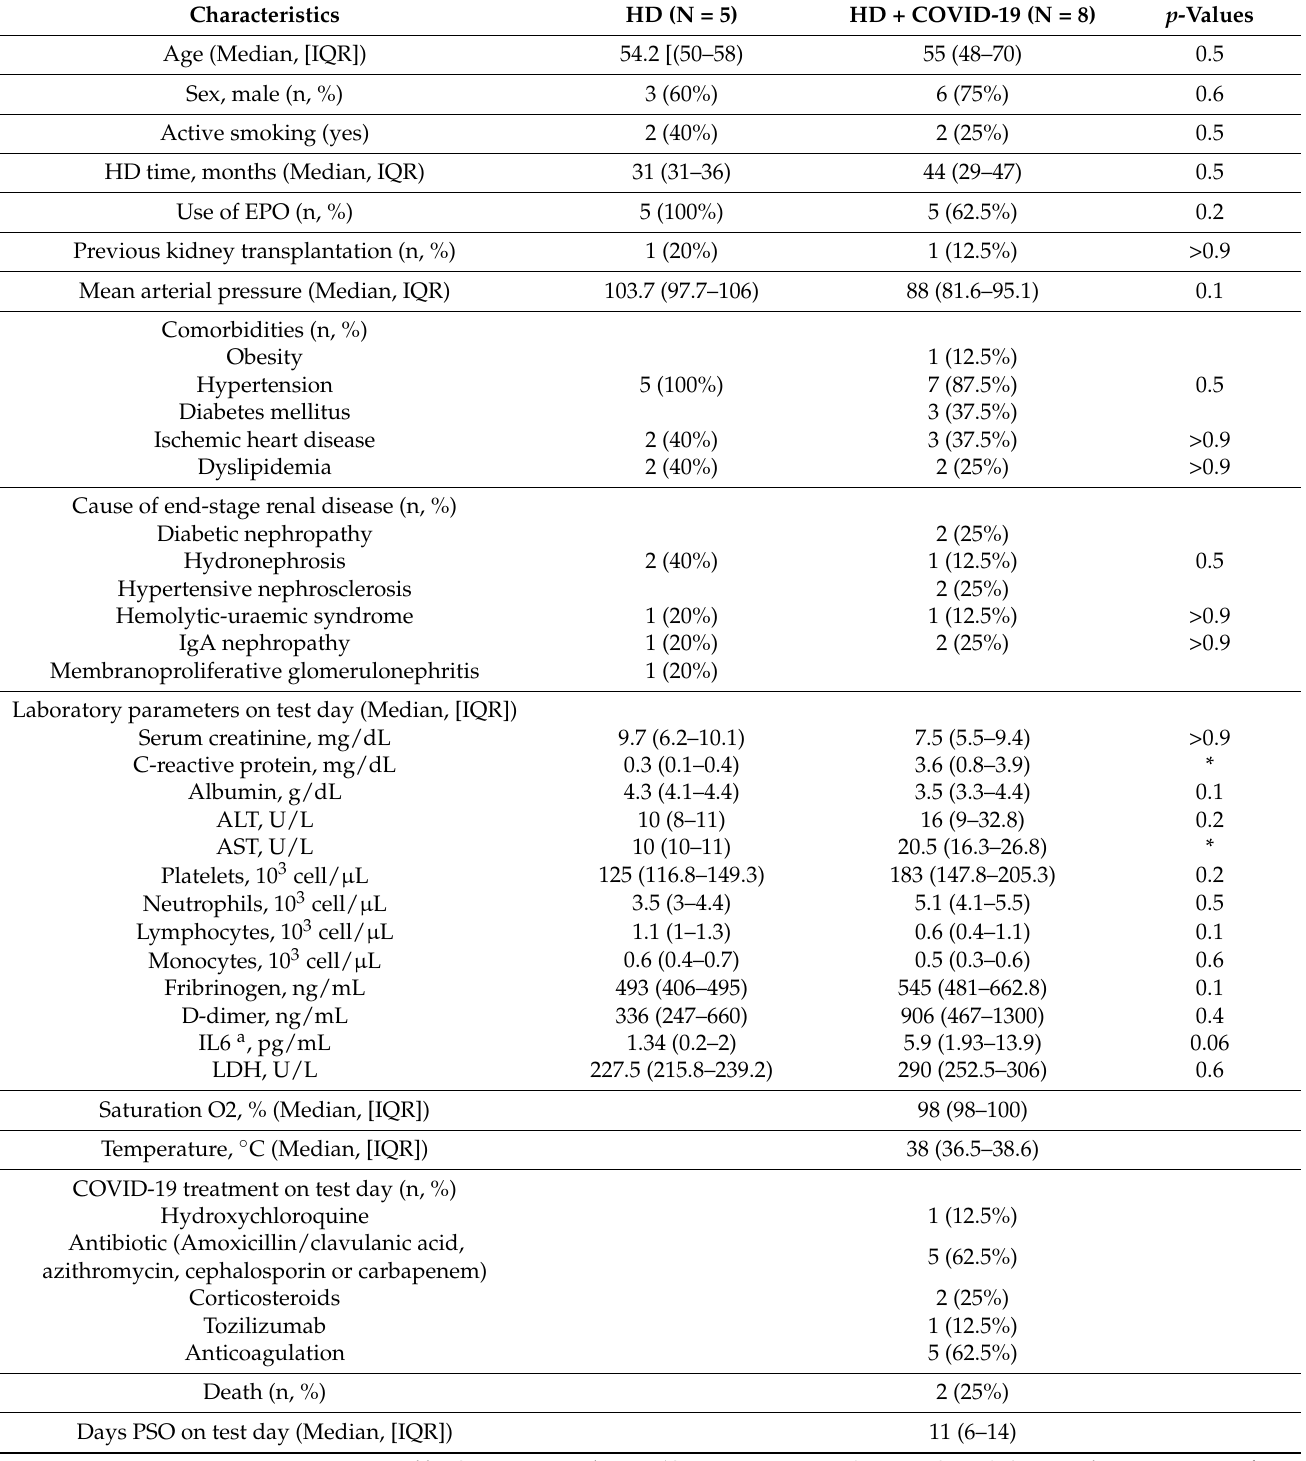
Table 1. Characteristics of HD patients with and without active infection by